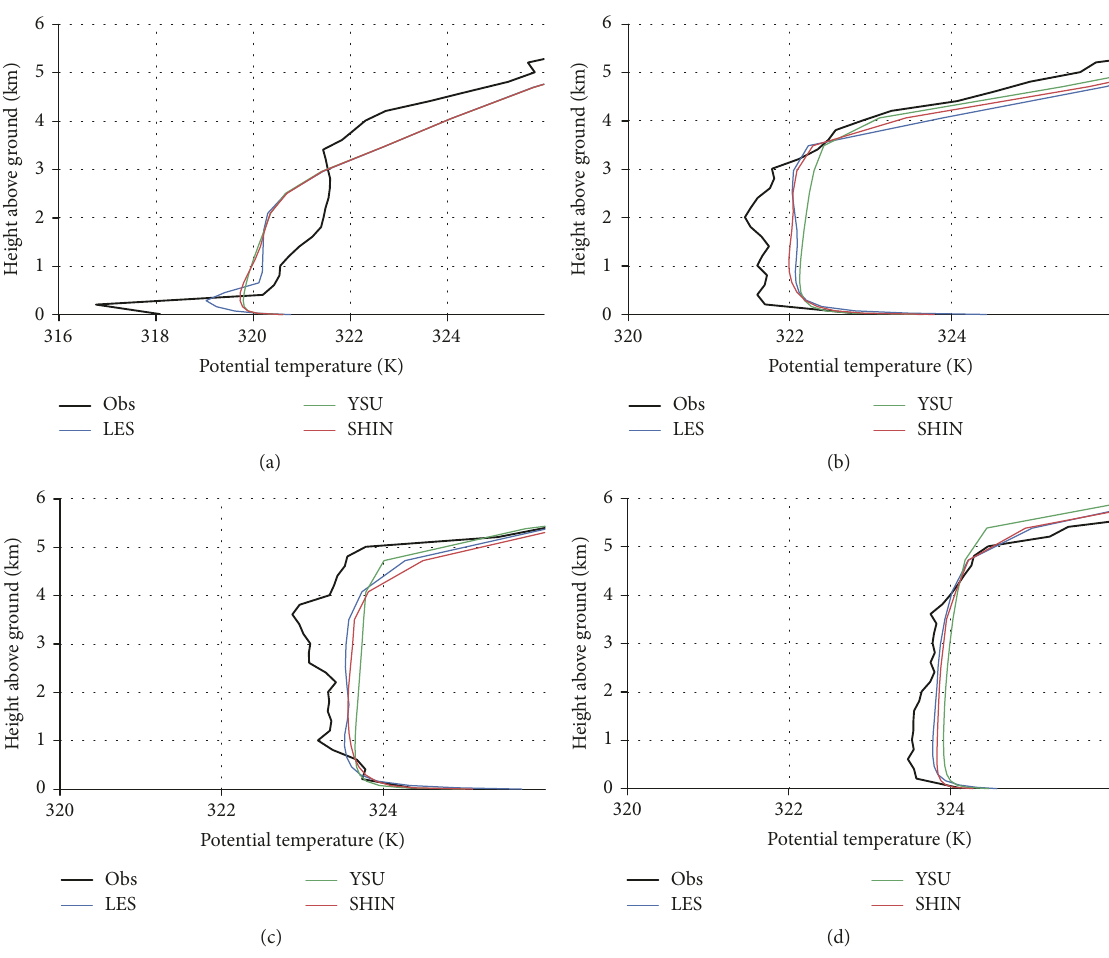
Figure 2: Vertical profiles of potential temperature (units: K) from simulations and observation of GPS sounding at Tazhong station (83.63 ∘ E, 39.03 ∘ N) at (a) 1100, (b) 1400, (c) 1700, and (d) 2000 BJT, 1 July